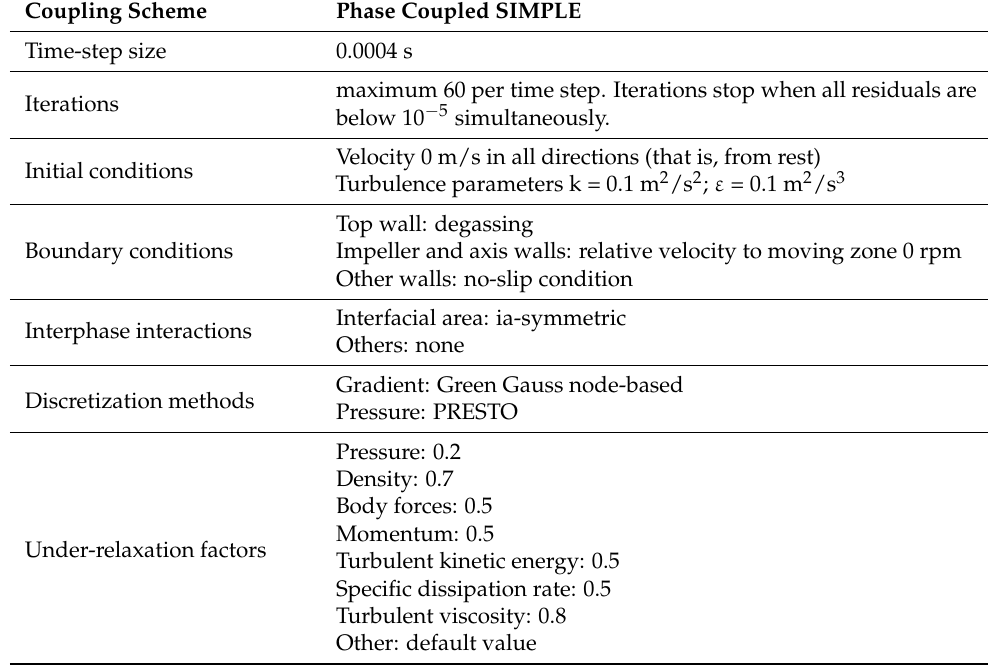
Table 3. Settings used for the CFD model of Xanthan Sol